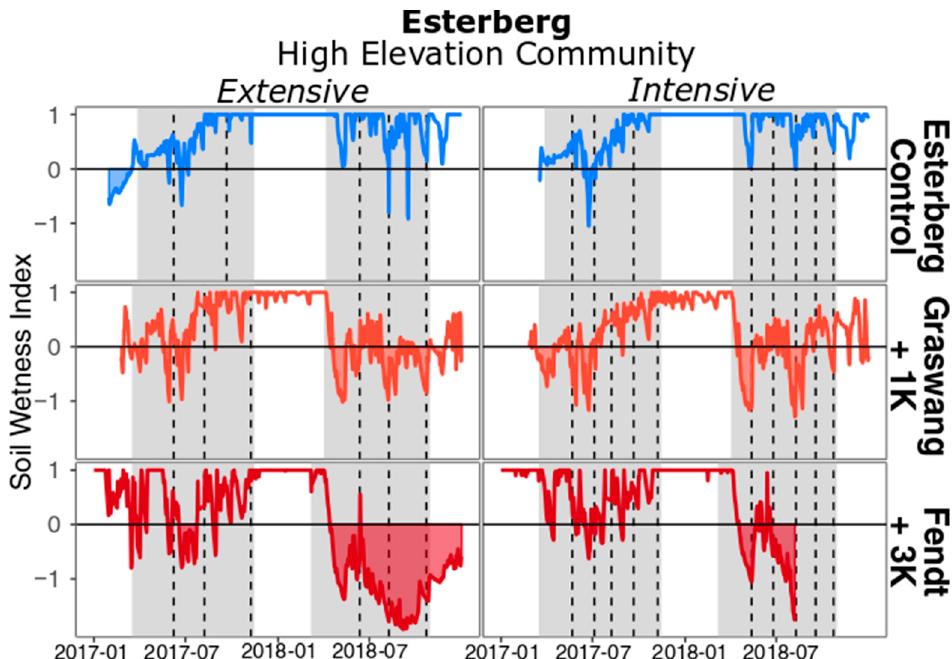
Figure 4. Soil wetness index of communities originating from high-elevation site (Esterberg) under extensive (left column) and intensive (right column) land-use intensity, at their respective recipient site: control (top), +1 K (center), and +3 K (bottom). The growing season (grey shaded areas) of 2018 reveals more pronounced dry spells (area with wetness index < 0) than 2017, especially at mid- and low-elevation sites. Dashed lines indicate date of harvest.